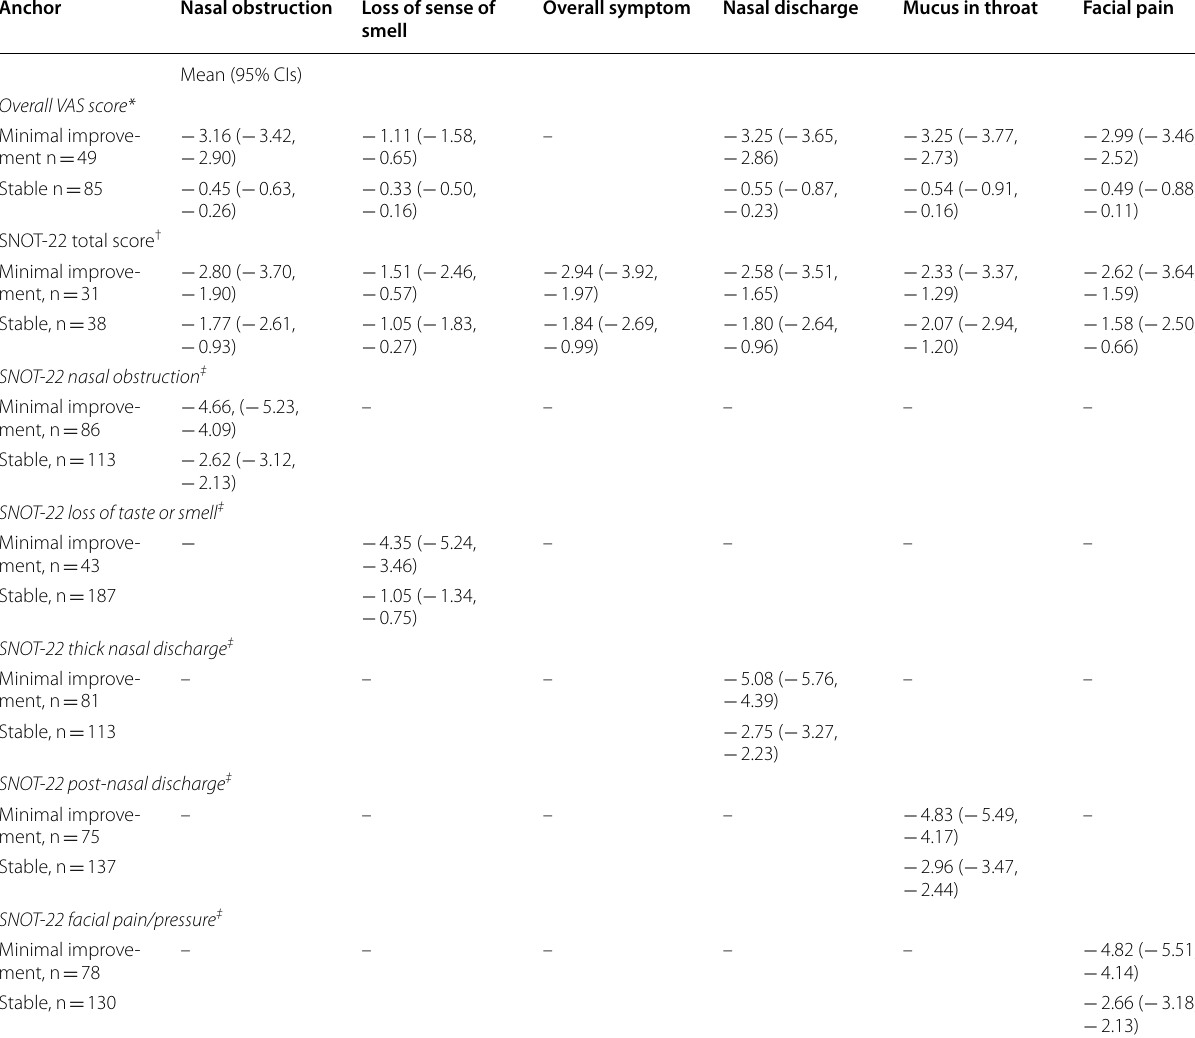
Table 2 Anchor-based change from baseline to Week 52 for individual VAS